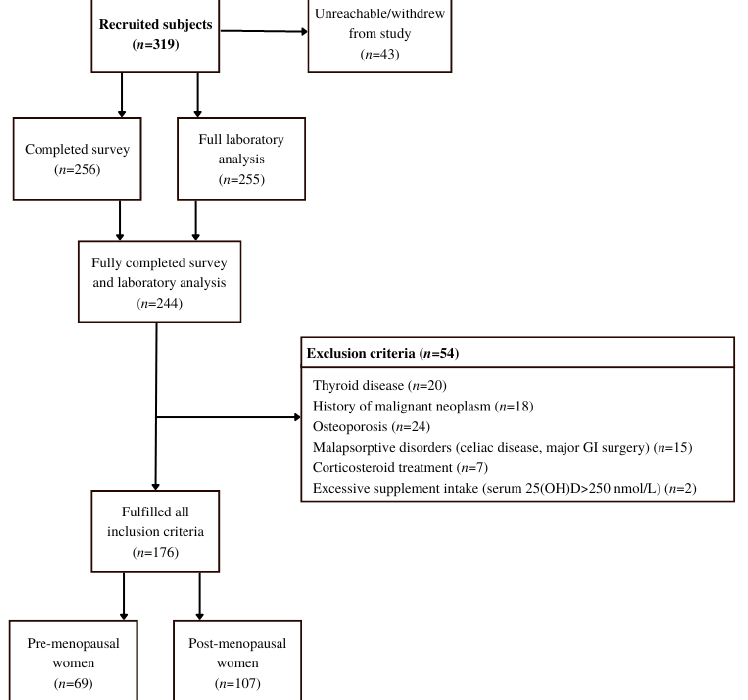
Figure 2. Flow chart of the study that included healthy women from the Central Slovenian region aged between 44 and 65 and was carried out between 1 March 2021 and 31 May 2021.